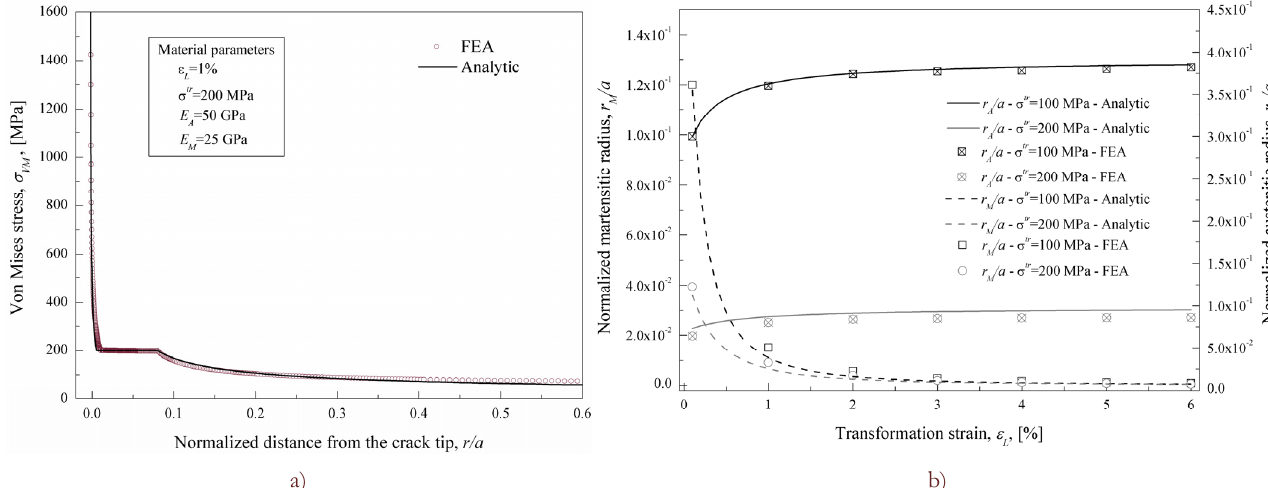
Figure 4: Comparisons between analytical and FE results: a) crack tip von Mises stress and b) transformation radii as a function the  )and for two values of the transformation stress ( tr transformation strain ( L